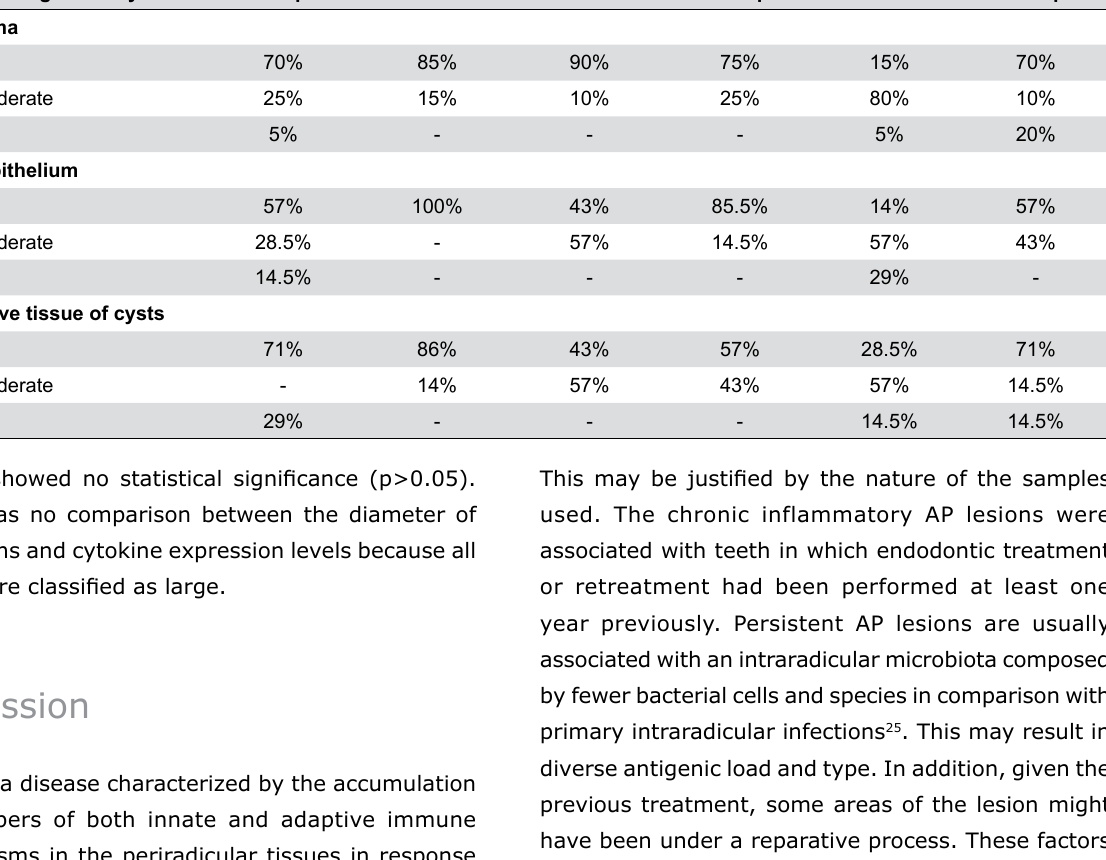
Pro-inflammatory and anti-inflammatory cytokine expression in post-treatment apical